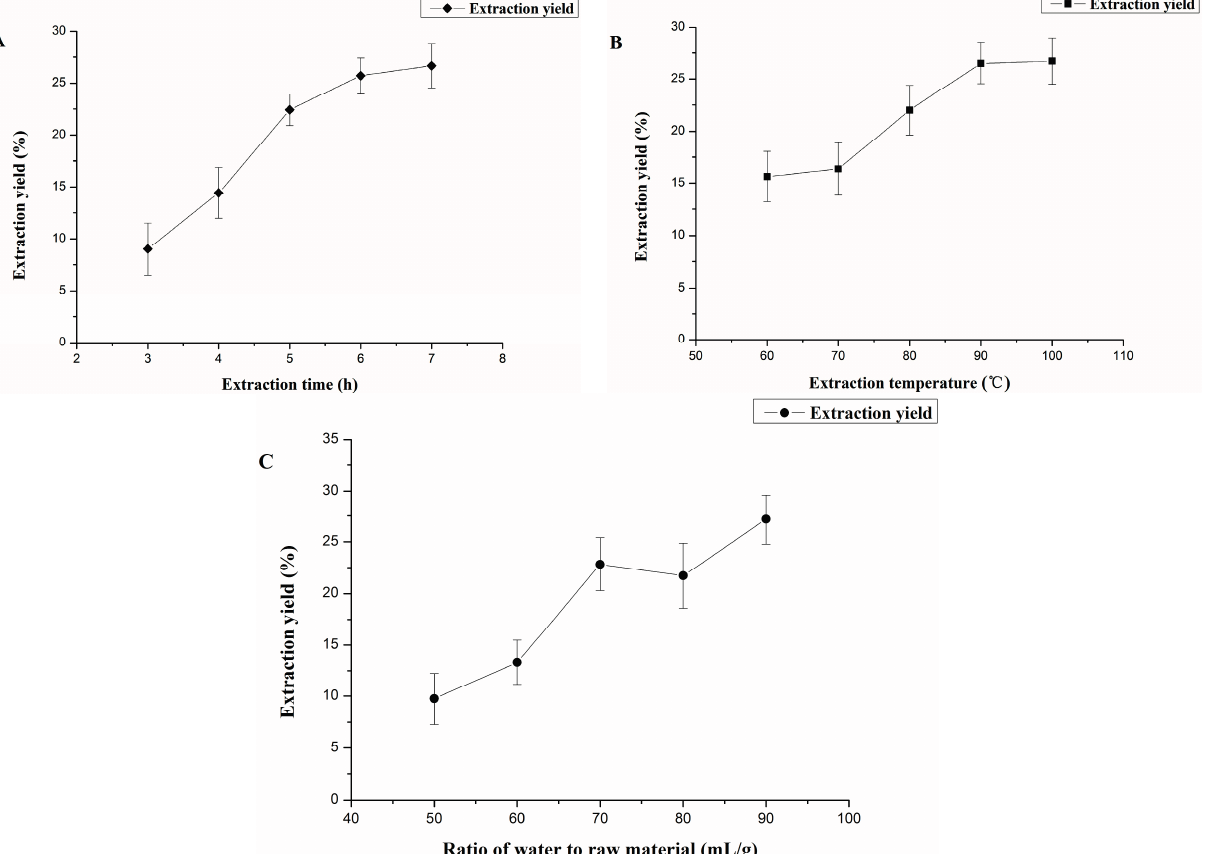
Figure 1. Effect of extraction time ( A ); extraction temperature ( B ); and ratio of water to raw material ( C ) on extraction yield of G. livida (Harv.) Yamada (GL)